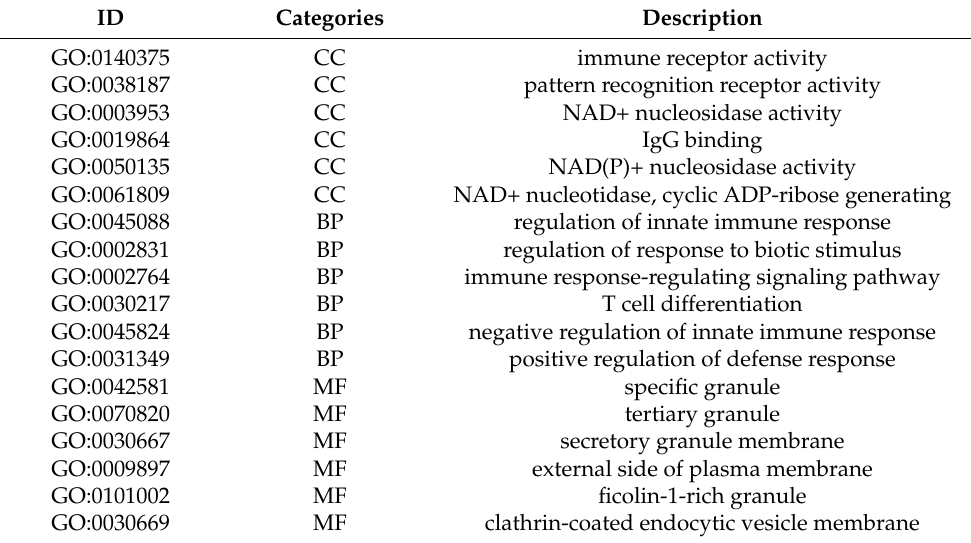
Figure 8. Distribution of DEGs in GO enrichment analysis. The order of the circles is from the outside in. The first circle shows the most significantly enriched terms of biological process (BP), cellular component (CC), and molecular function (MF), with the scale outside corresponding to the number of genes. The second circle shows the number of background genes in the corresponding GO terms and the p -value. The third circle shows the number of DEGs. The inner circle shows the enrichment score of the corresponding GO terms. Table 1. The top six most significant GO terms enriched by the 239